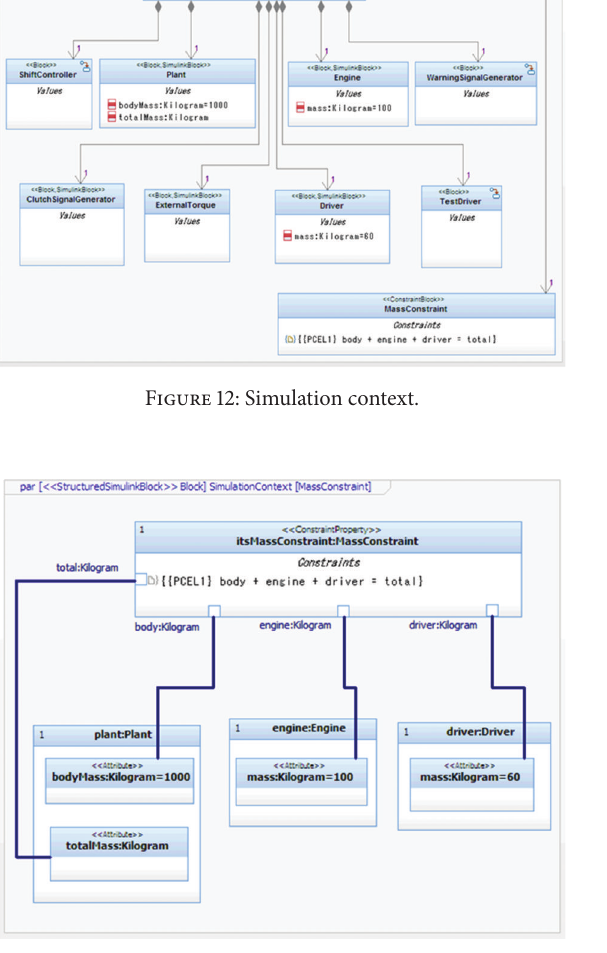
Figure 13: Parametric diagram to define relationships between